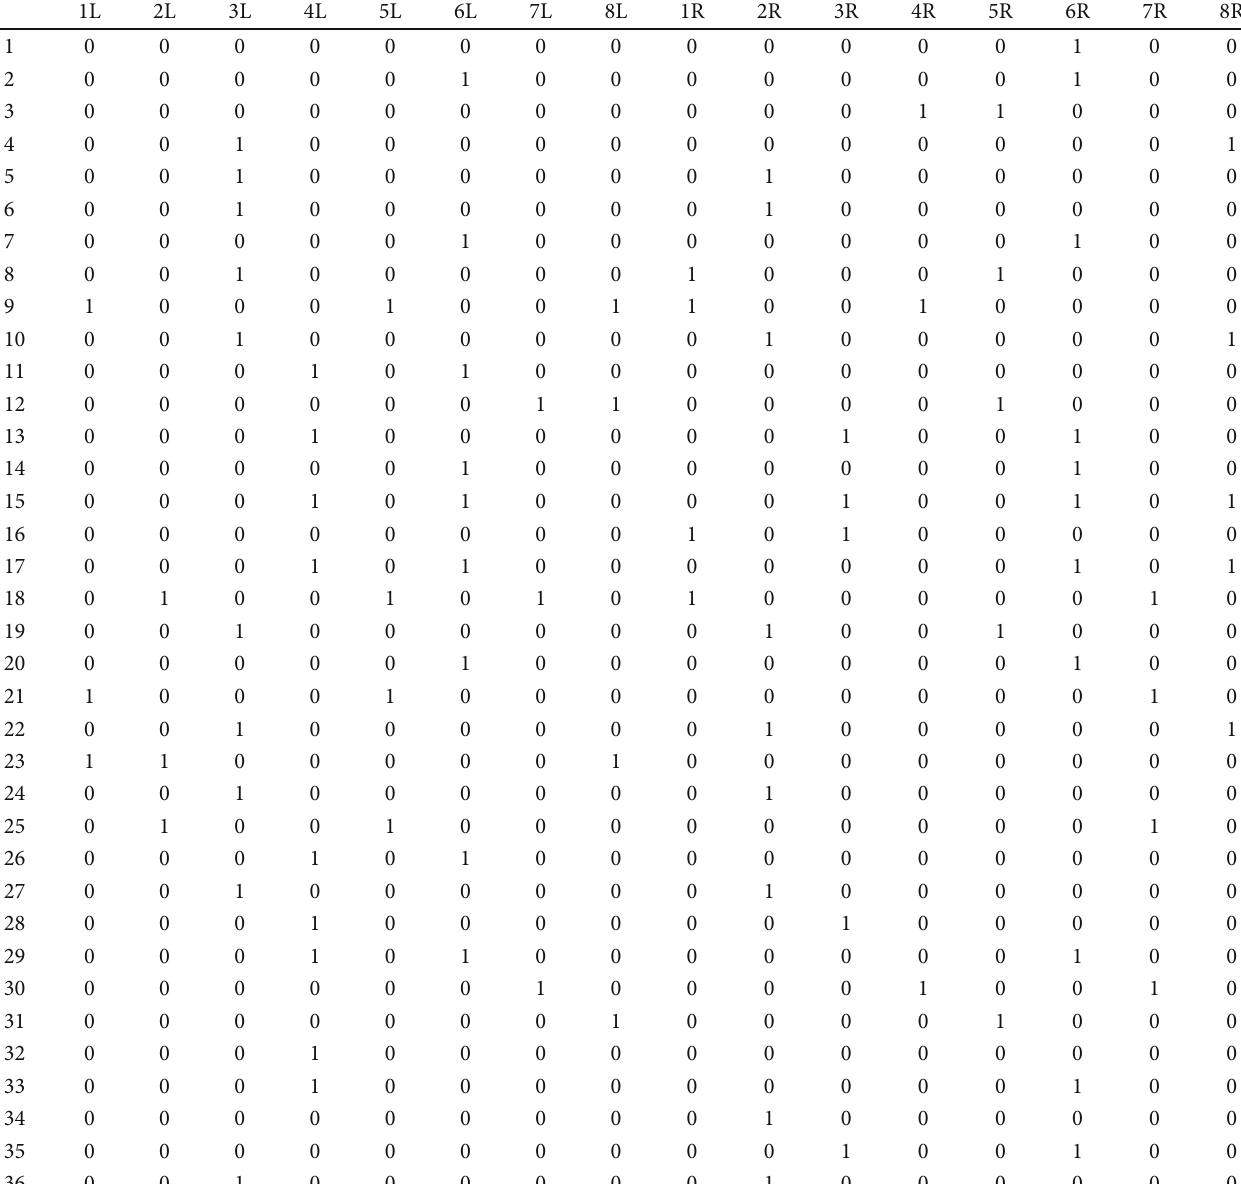
Table 4: Details about resource allocation in the optimization